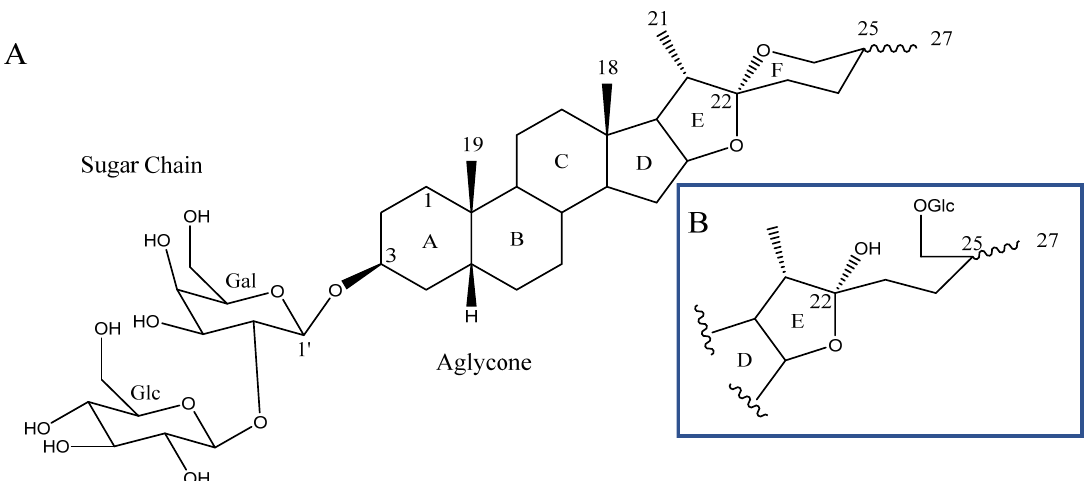
Figure 1. ( A ) Structure of a spirostanic saponin. ( B ) C-22 to C-27 carbons of a furostanic saponin.